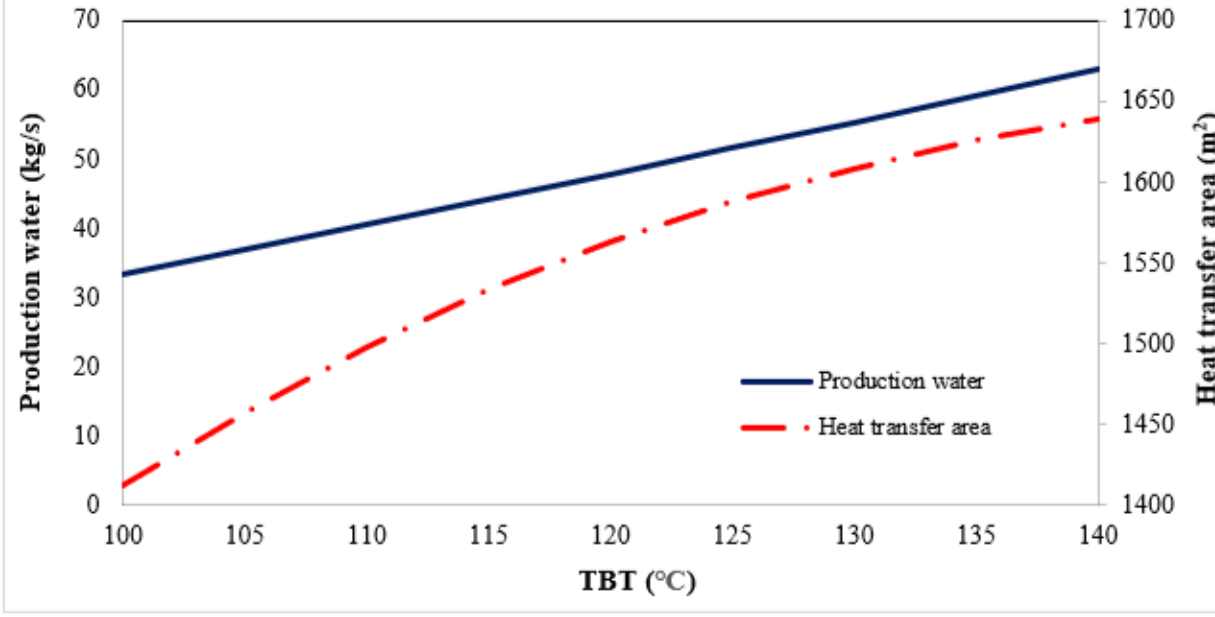
Figure 7. Variations of distillate water and heat transfer area in terms of top brine